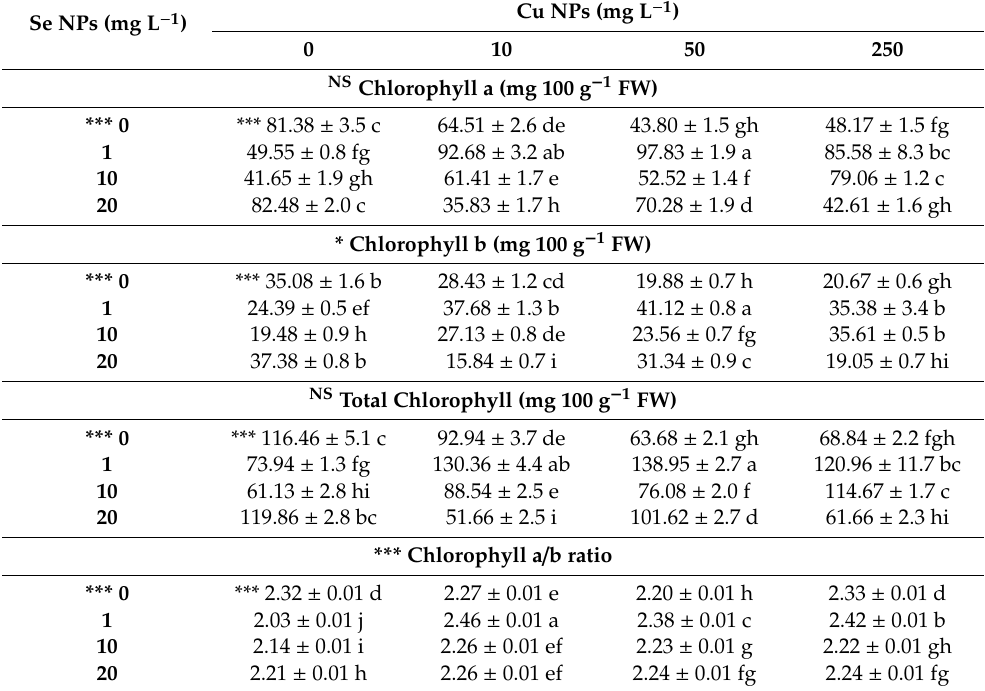
Table 2. Chlorophyll content in tomato leaves from plants treated with Se and Cu